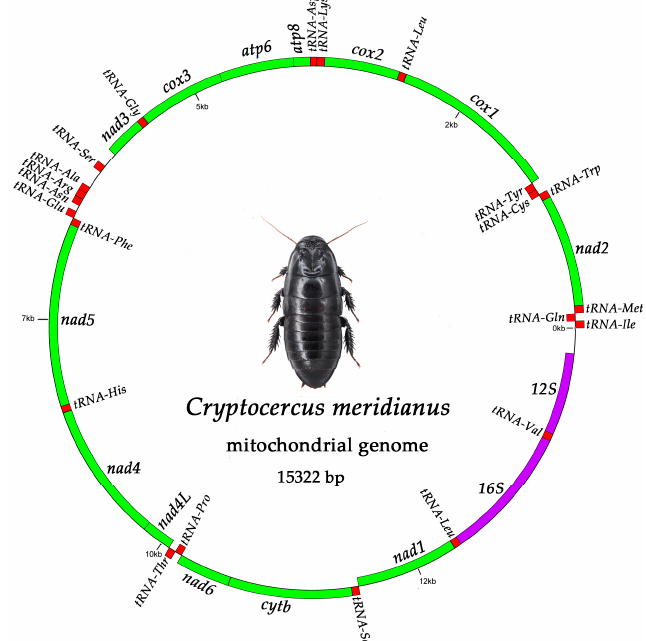
Figure 1. Genetic map of the complete mitochondrial genome of C. meridianus . The genes are abbreviated as follows: nad1 , 2 , 3 , 4 , 4L , 5 , 6 refer to nicotinamide adenine dinucleotide subunit; cox1 , 2 , 3 refer to cytochrome oxidase subunit; 16S refers to large subunit of ribosomal RNA gene, 12S refers to small subunit of ribosomal RNA gene; atp6 , 8 refer to ATP synthase F0 subunit; cytb refers to cytochrome B. tRNAs are red colored, protein coding genes (PCGs) are green colored, rRNAs are purple colored. Genes on the light strand are encoded in clockwise orientation; genes on the heavy strand are encoded in anti-clockwise orientation. Table 1. Size, AT content (%) for C. meridianus , C. relictus , and C. kyebangensis mitogenomes.